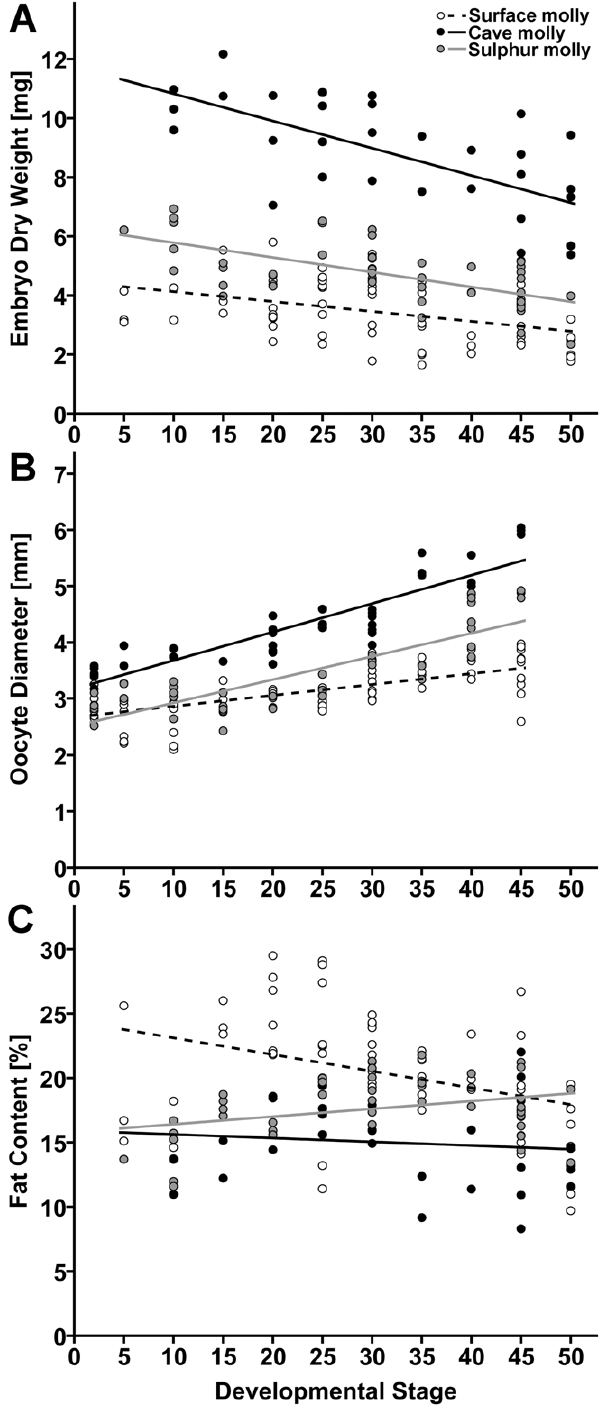
Figure 5. How to increase offspring size during development. Scatter plots depicting ( A ) embryo dry weight, ( B ) ovum diameter, and ( C ) embryo fat content in the course of development in molly embryos from one benign and two extreme habitats. Test statistics are presented in the results section.